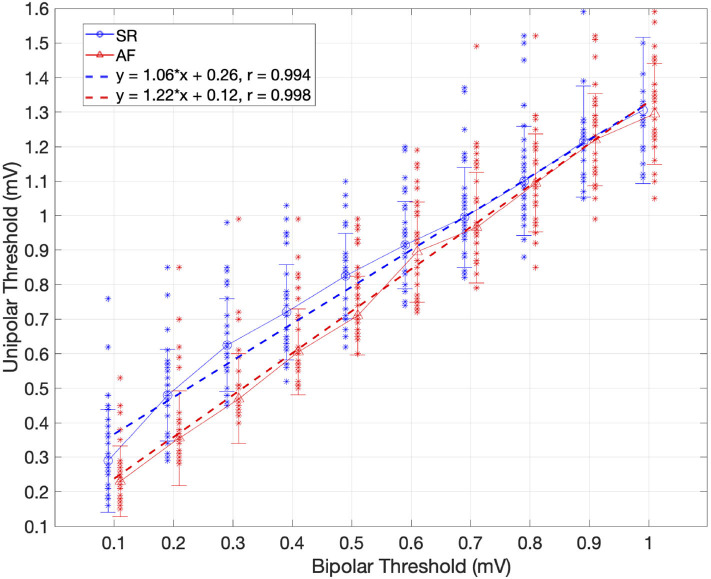
Relationship between the bipolar and unipolar threshold in SR (blue) and AF (red). The unipolar threshold with highest concordance to the bipolar map is shown for different bipolar thresholds and each individual patient (blue and red dots for SR and AF, respectively). Standard deviation is represented by bars. The optimal unipolar threshold is identified as the optimal point on the ROC curve of each bipolar threshold using all patients. Linear regression shown as dotted lines, depending on the rhythm (SR blue, AF red). Pearson correlation coefficient (r) is provided. For every unipolar threshold, >89% of points matched in SR and >86% in AF.